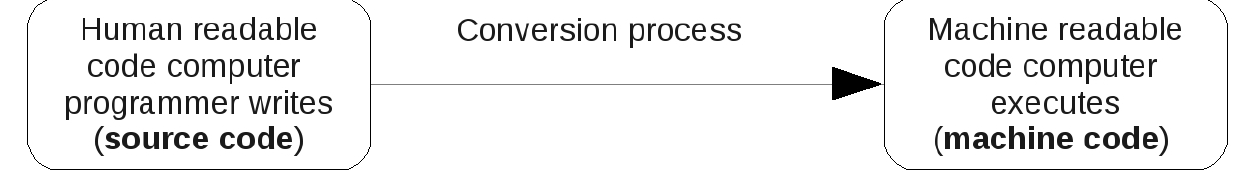
Figure 1. The programmer writes source code, which is converted to the machine code that the computer